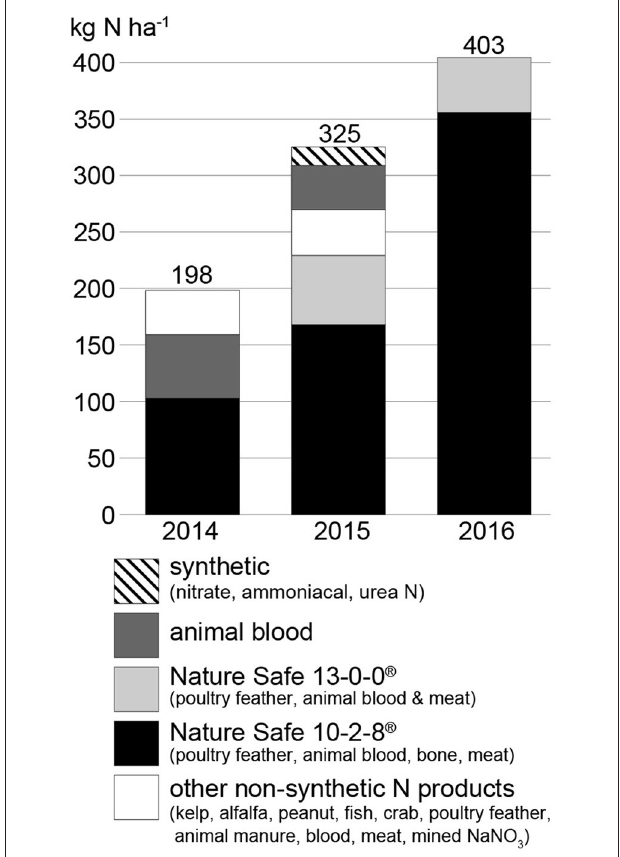
FIGURE 3 | N input by fertilizer application and N sources at the Brooklyn Grange Navy Yard farm, NYC. All values are expressed in terms of the area of the planting beds